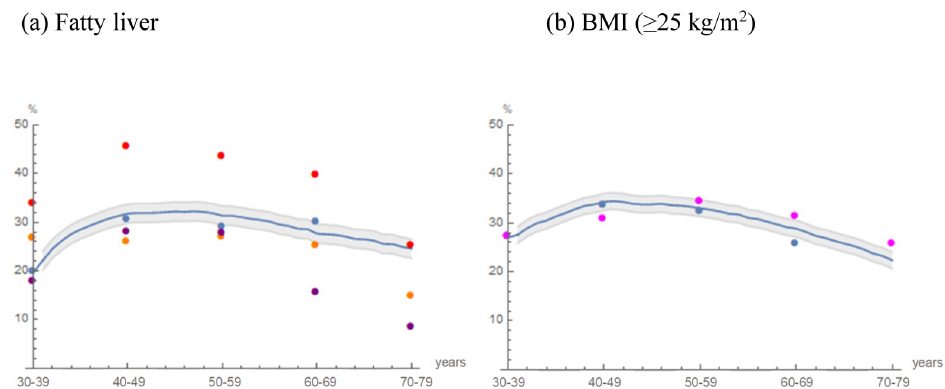
Fig 3. Projected prevalence in cohort 2 and recorded prevalence in external populations: (a) Fatty liver, (b) BMI ( � 25 kg/m 2 ). The trajectories of the projected prevalence in cohort 2 (blue curve) are illustrated. Areas in gray indicate the mean prevalence within ± 2 SD as Monte Carlo variations. Blue dots indicate the prevalence in the study population recorded in 2012–2016 (n = 10179). Observed external population data were indicated by purple [29], orange [4], red [28] and magenta dots